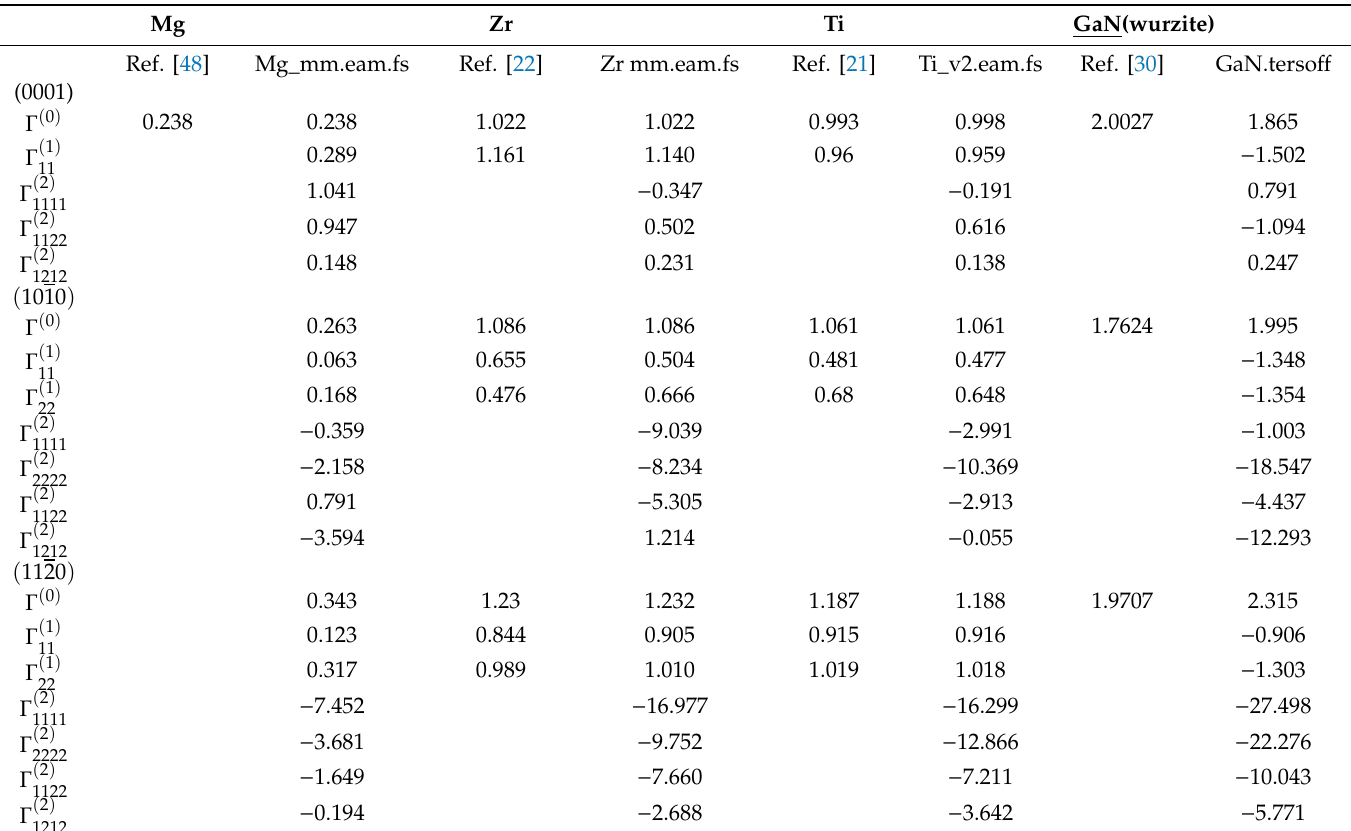
Table 5. Surface properties of hexagonal crystals (unit: J / m 2